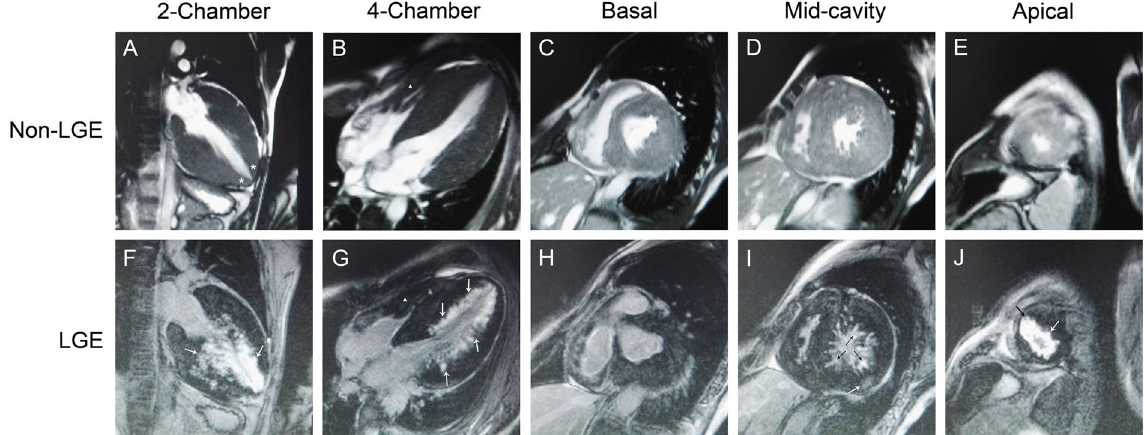
Figure 3. Normal and contrast-enhanced CMR images in individual III-5 who suffered from SCD at age 24. Two chamber and four chamber cine images show remarked LVH and mild RVH ( ▲ ), with apical involvement ( * ) ( A , B ). Basal, mid, and apical LV short-axis images show hypertrophy in almost all segments, with a maximal LV wall thickness of 33 mm and the maximal RV wall thickness of 14 mm ( C – E ). Arrows indicate late gadolinium enhancement. LV hypertrophic regions exhibit patchy, subendocardial and midmyocardial late gadolinium enhancement ( F – J ) (white and black arrows). SCD, sudden cardiac death; LVH, left ventricular hypertrophy; RVH, right ventricular hypertrophy; LV, left ventricle.